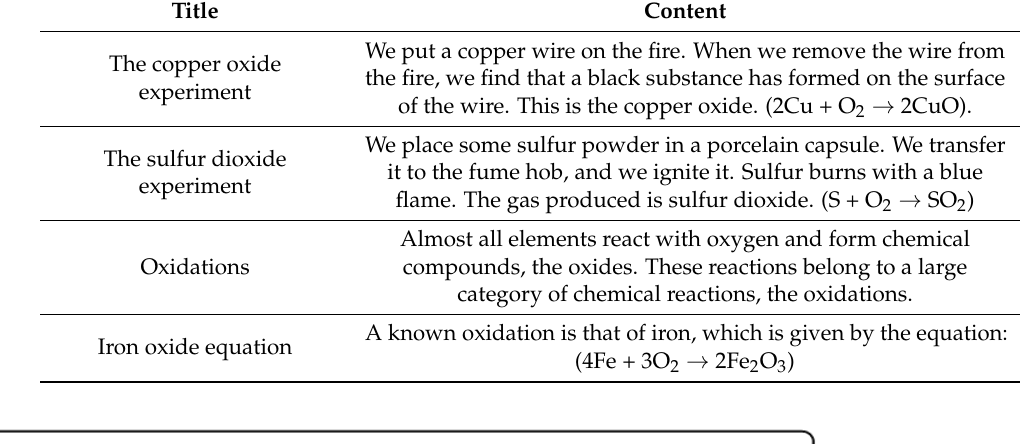
Table 3. Educational Content.